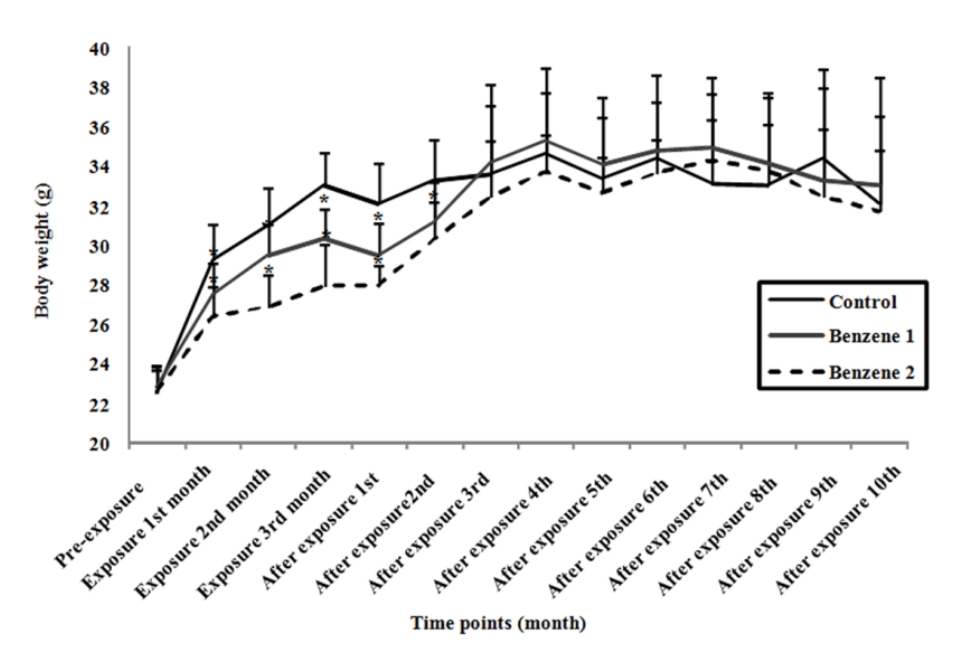
Figure 1. Body weight of C3H/He mice at different time points. The body weight was monitored each month. Values are expressed as mean ± standard deviation (SD).